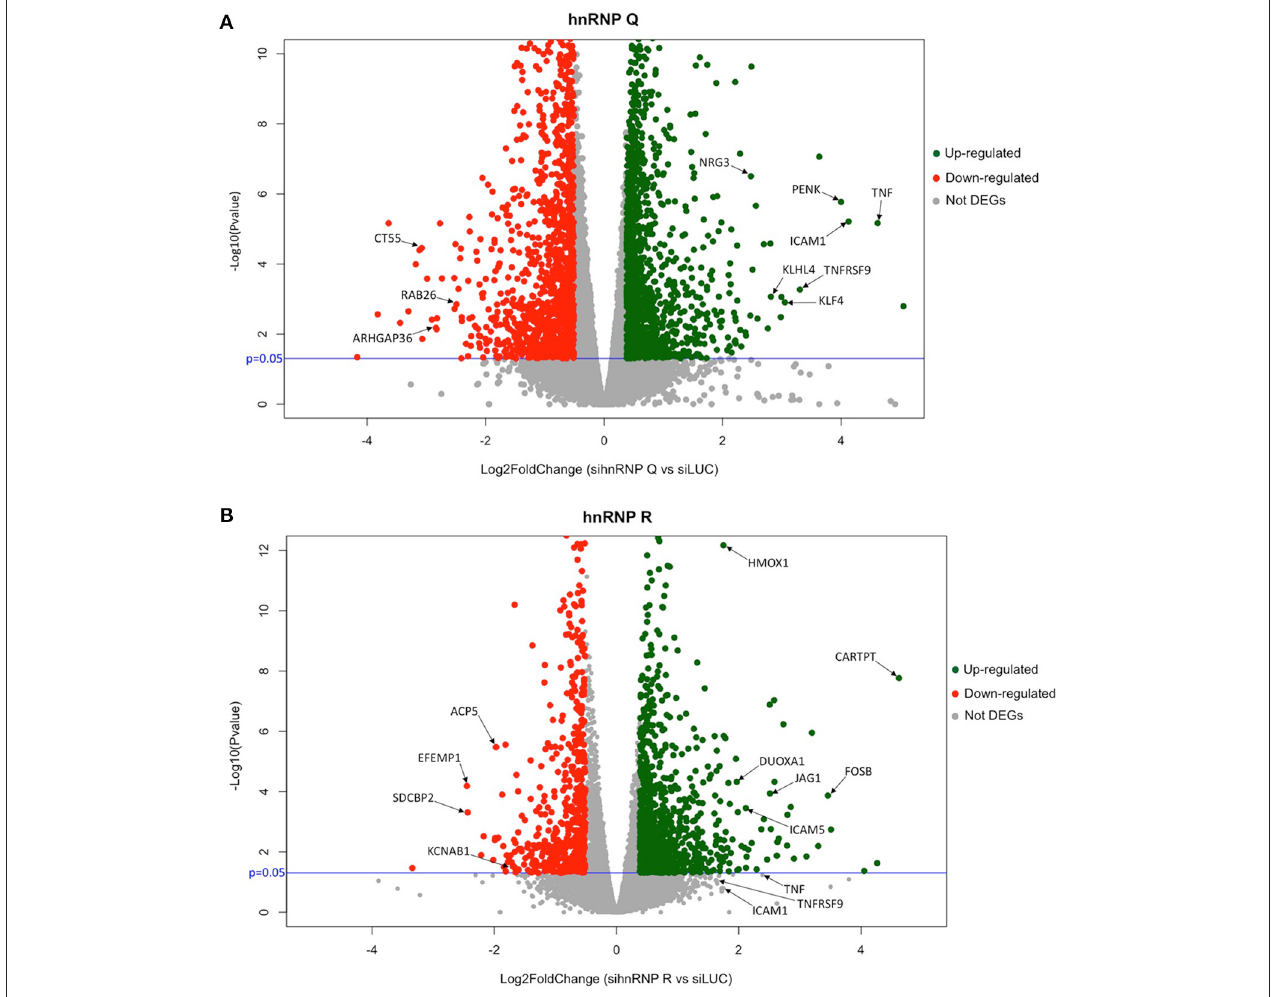
FIGURE 6 | Volcano plot of hnRNP Q and hnRNP R. Schematic representation of RNA-seq data of sihnRNP Q (A) and sihnRNP R (B) treated cells. Up- and downregulated genes are reported as green and red dots, respectively. Not DEGs are represented as gray dots. Black arrows show RT-qPCR validated genes. P threshold ( = 0.05) is reported in